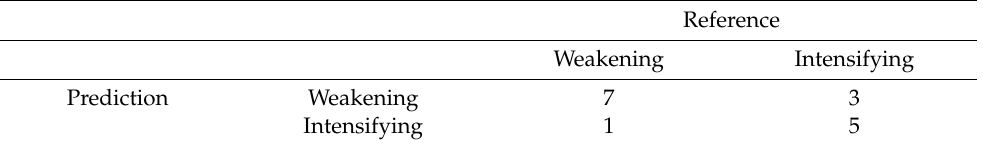
Figure 4. The comparisons of ( a ) classification accuracy, ( b ) sensitivity, ( c ) false alarm rate (FAR), and ( d ) AUC score of nine different random forest models using testing data for mainland landfall. White color values on the top of each bar indicate the model performance for the particular matrices. The yellow lines are defining the error bars. Table 5. Confusion matrix for the testing dataset produced from the LOOCV with ROSE sampling random forest with members trained using binary classes for mainland